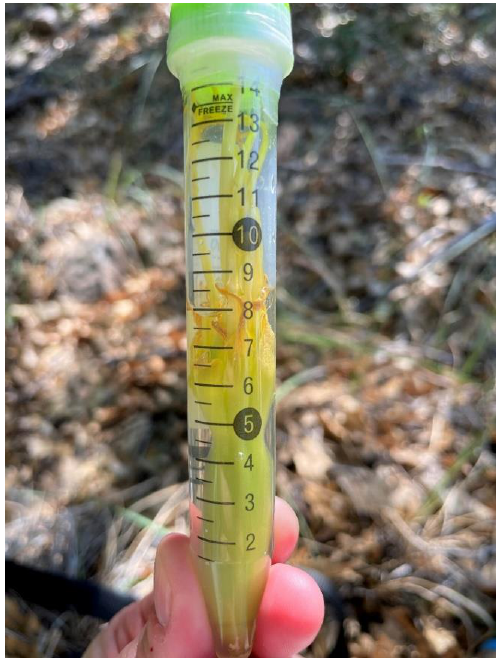
Figure 1. An agave flower placed into a 15 mL conical of RNAlater.